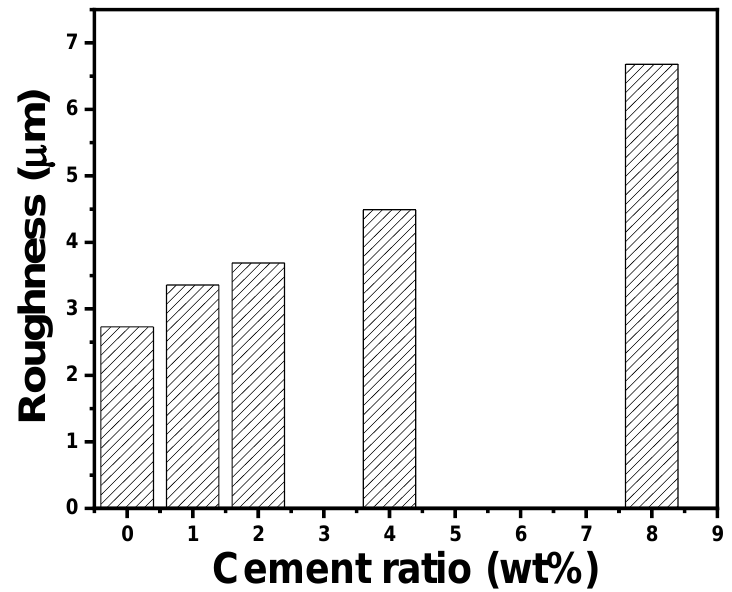
Figure 5. Roughness surface values of acrylic polymer/cement nanocomposites.